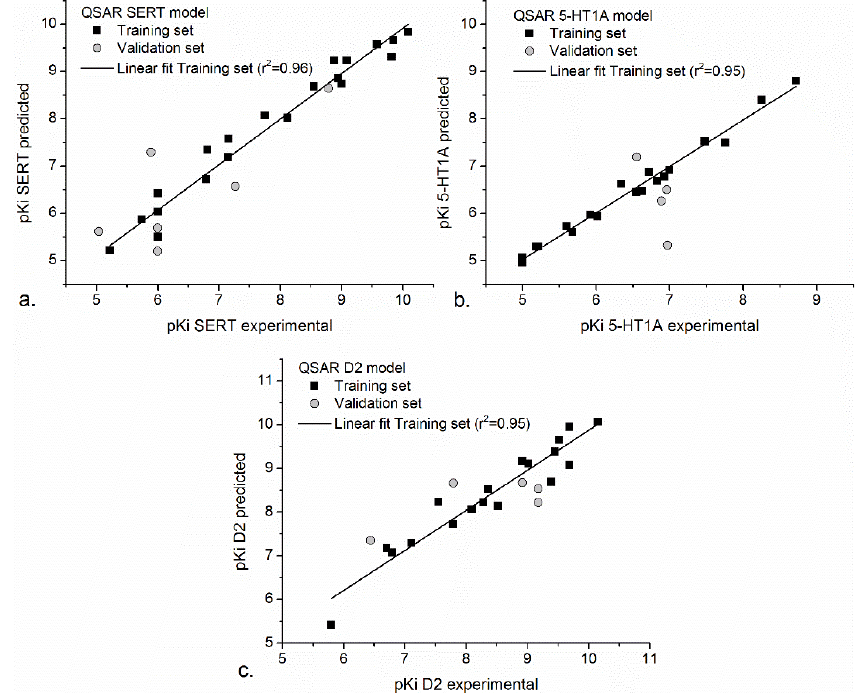
Figure 1. The correlation between experimental and predicted values of QSAR SERT ( a ), QSAR 5-HT1A ( b ), and QSAR D2 ( c ) models. Data were plotted and fitted using Origin Pro, version 9.2 (2015), OriginLab Corporation, Northampton, MA, USA.